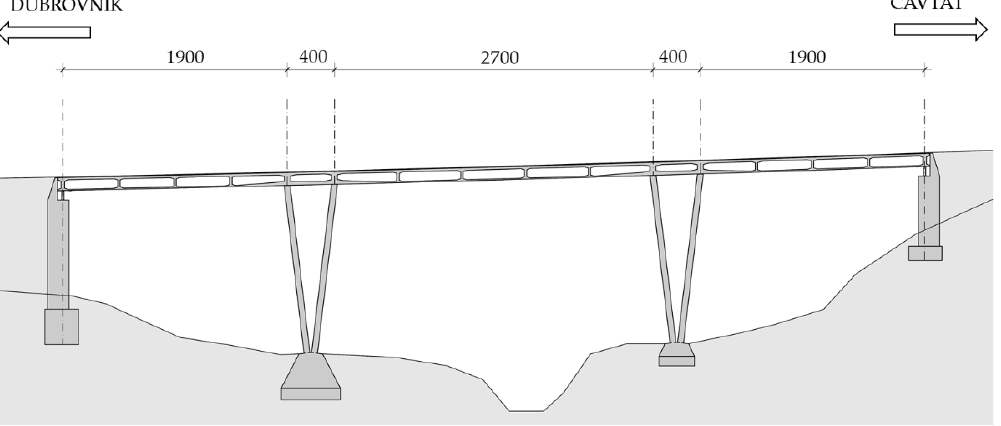
Figure 6. Longitudinal section of the first Case Study bridge (units in cm).